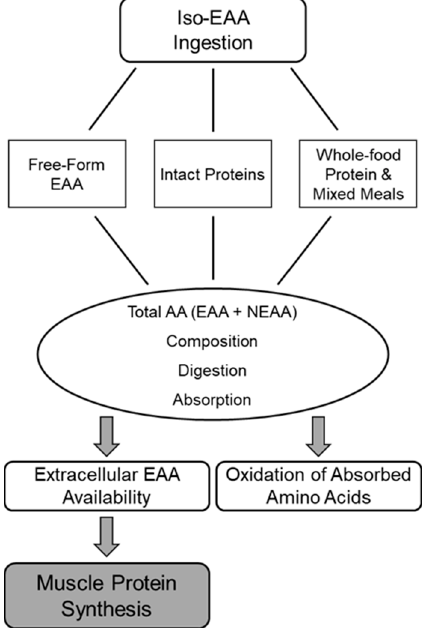
Figure 1. Factors moderating the effects of essential amino acids (EAA) on muscle protein synthesis.